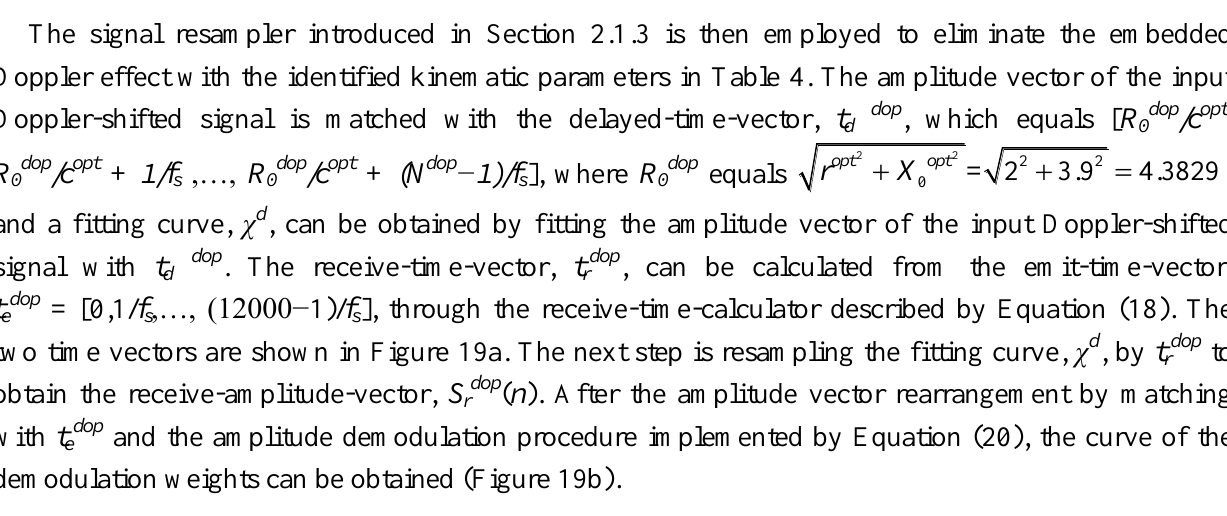
Figure 19. ( a ) Receive-time-vector (red curve) and the time vector of the source signal (blue curve) and ( b ) Curve of the demodulation weights, in the experimental case study of the bearing signal with the out-race